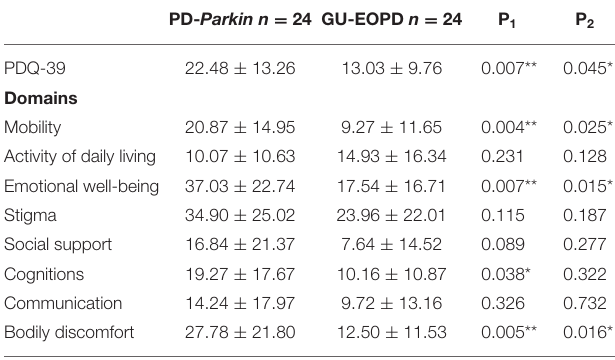
TABLE 3 | Correlated factors of QoL in PD- Parkin and GU-EOPD patients. PD- Parkin